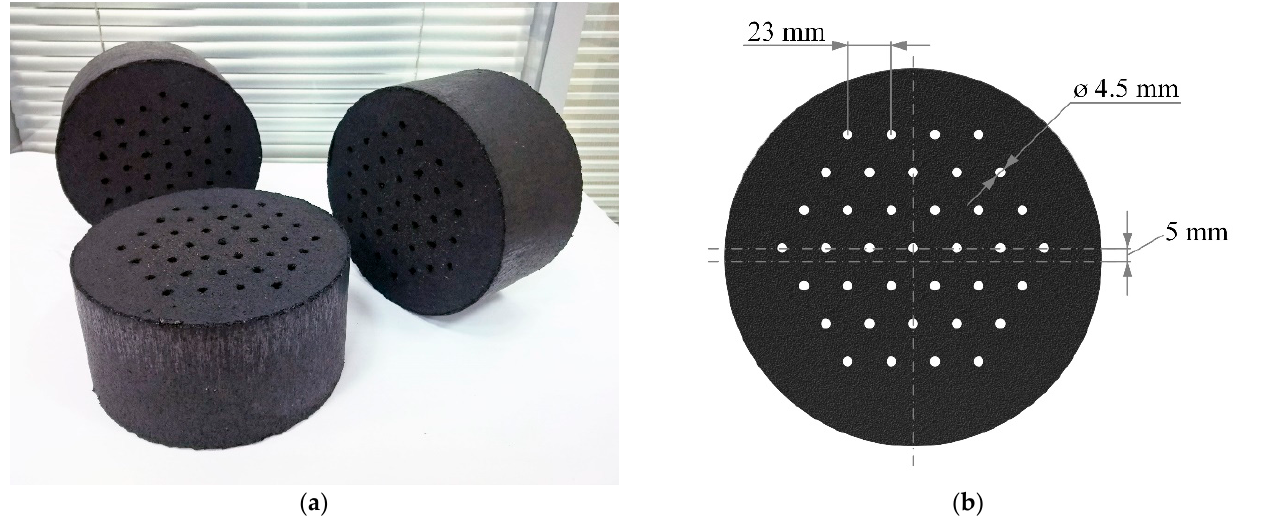
Figure 1. Samples of shaped monolithic carbon adsorbent AU-1 ( a ) and channels geometry of adsorbent monolith ( b ).